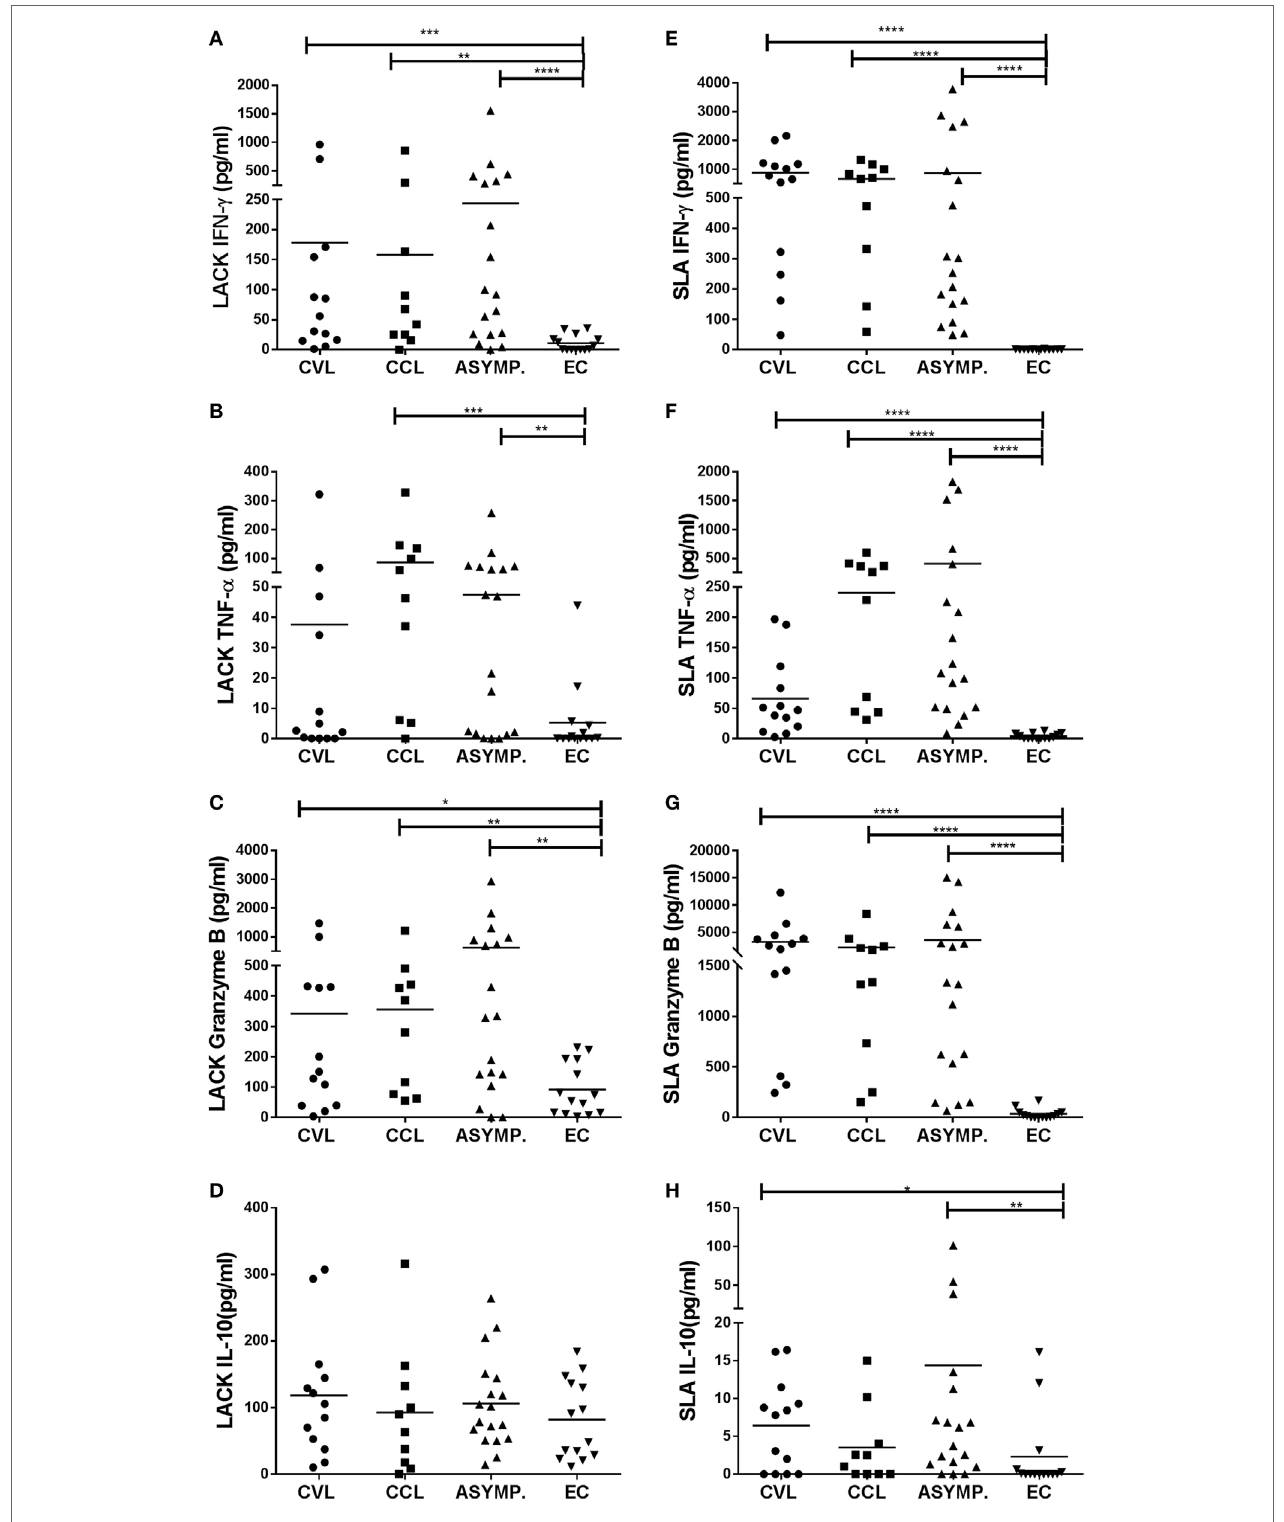
FigUre 1 | Production of IFN- γ , TNF- α , granzyme B, and IL-10 in peripheral blood mononuclear cells stimulated with Leishmania -activated C-kinase antigen [ (a–D) respectively], and with soluble Leishmania antigen [ (e–h) respectively], in healthy controls (EC, n = 14), asymptomatic subjects (ASYMP, n = 18), patients cured of cutaneous leishmaniasis (CCL, n = 10), and patients cured of visceral leishmaniasis (CVL, n = 13). * p ≤ 0.05, ** p ≤ 0.01, *** p ≤ 0.001, **** p ≤